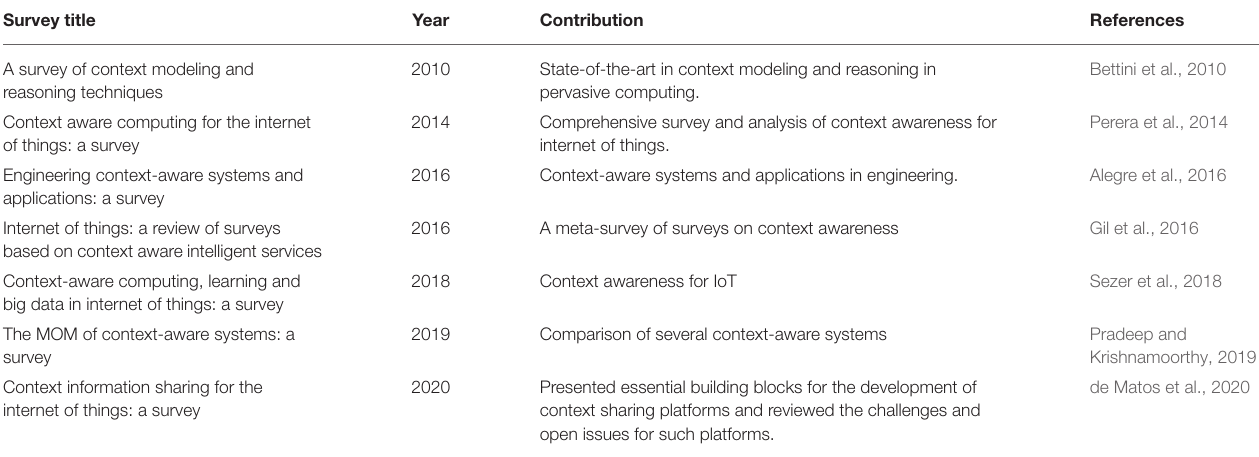
TABLE 2 | Summary of IoT context-aware system